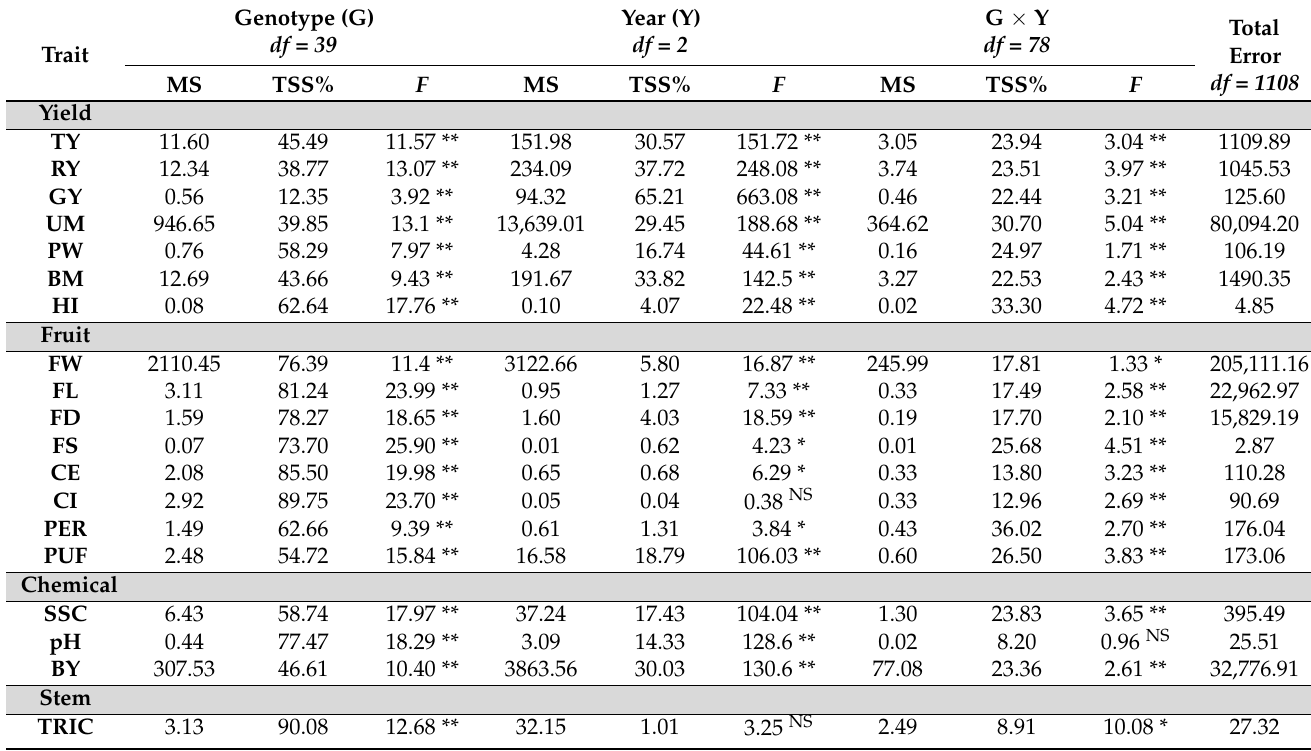
Table 4. Analysis of variance and significant levels for the genotypic (G) and environmental effects due to growing season (Y) for Solanum habrochaites (SH) ILs and the SL control, and the combined effects for the traits evaluated.